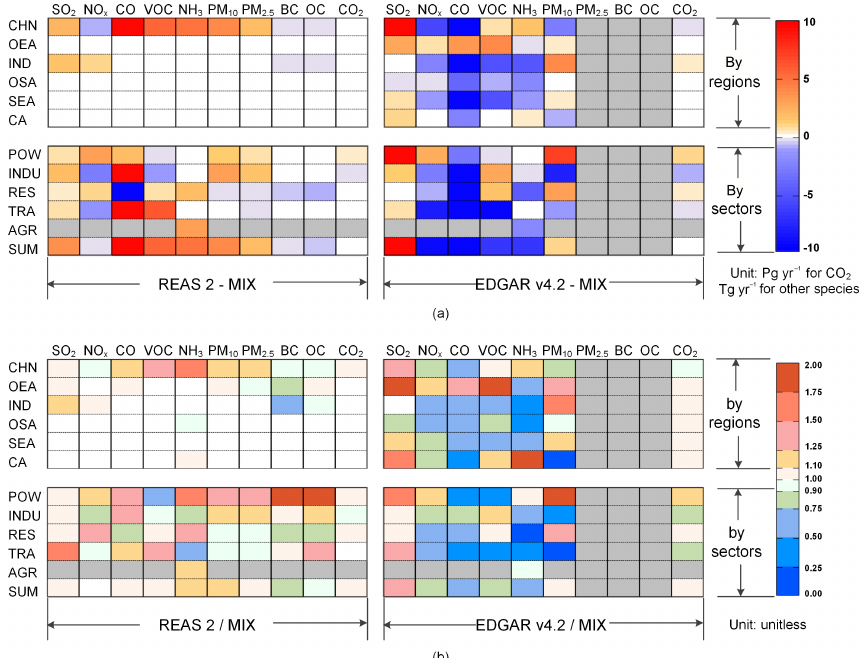
Figure 13. Intercomparisons of emission estimates between MIX, REAS2, and EDGAR v4.2 by Asian regions and sectors. (a) Absolute differences of emission estimates. (b) Ratio of emission estimates. Grey shaded grids indicate that the comparison is not available due to absence of emission estimates in EDGAR v4.2. Abbreviations of Asian countries and regions are the same as in Fig. 7. Abbreviations of sectors are as follows: POW is power plants; INDU is industry; RES is residential; TRA is transportation; AGR is agriculture; SUM is total. Russia Asia is not included in the